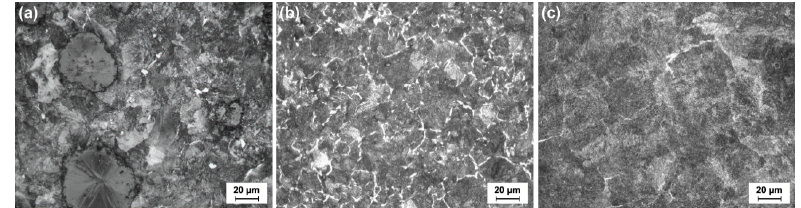
Figure 4. Microstructures of the testing materials: ( a ) ductile iron wheel after heat treatment, ( b ) carbon steel wheel, and ( c ) rail. Table 1. Chemical compositions of the testing materials (wt%).